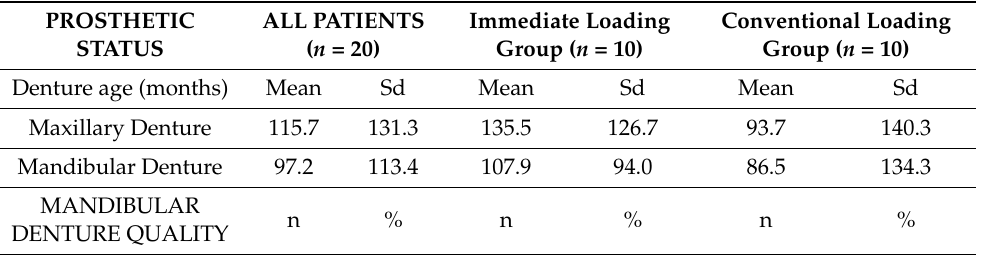
Table 2. Denture age and prosthetic status at baseline according to four parameters (retention, stability, interocclusal distance, and bibalanced occlusion) in the study sample ( n =